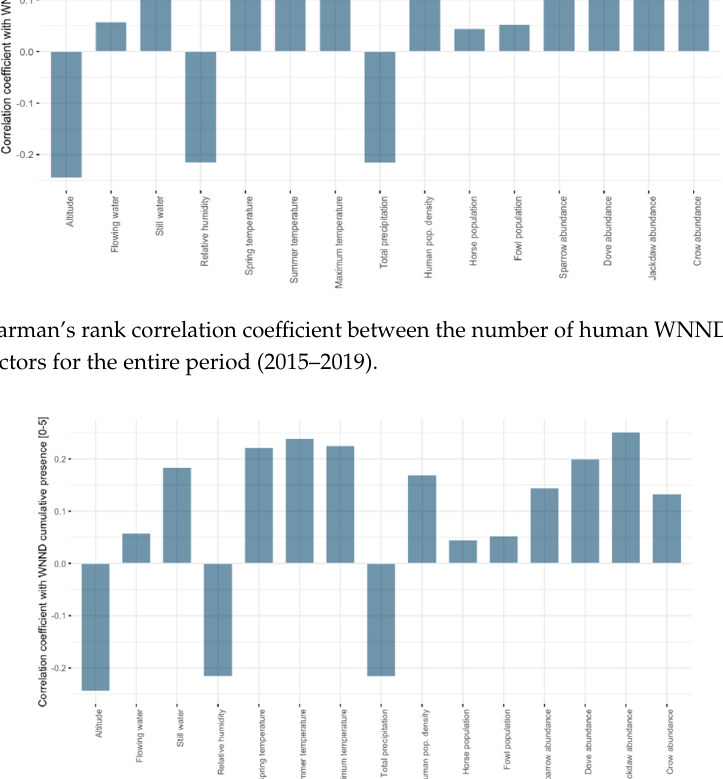
Figure 7. Spearman’s rank correlation coefficient between the biotic and abiotic predictors. The predicted probabilities of human WNND occurrence in Romania are shown in Figure 8. The higher probability area is located in the south and southeast part of the country. The lowest probability for human WNND occurrence is located in the high-elevation region along the Western, Eastern, and Southern Carpathians. The Transylvanian plateau has a slightly higher predicted probability of human WNND presence. Several patches of higher predicted probability are present along the western border. The highest predicted probability is around urbanized patches in the southeast, especially in the highly populated area around Bucharest.